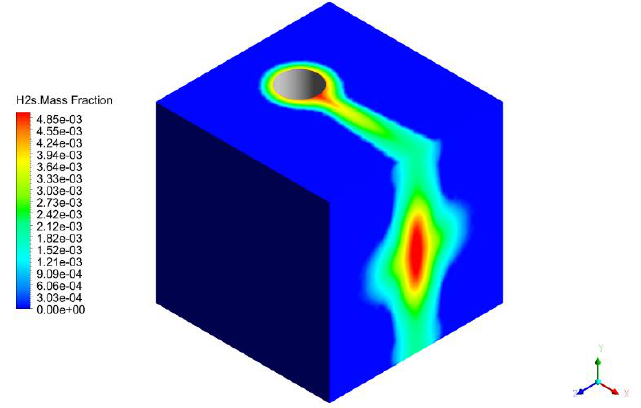
Figure 9. H 2 S m.f. contour plot on the SB faces.